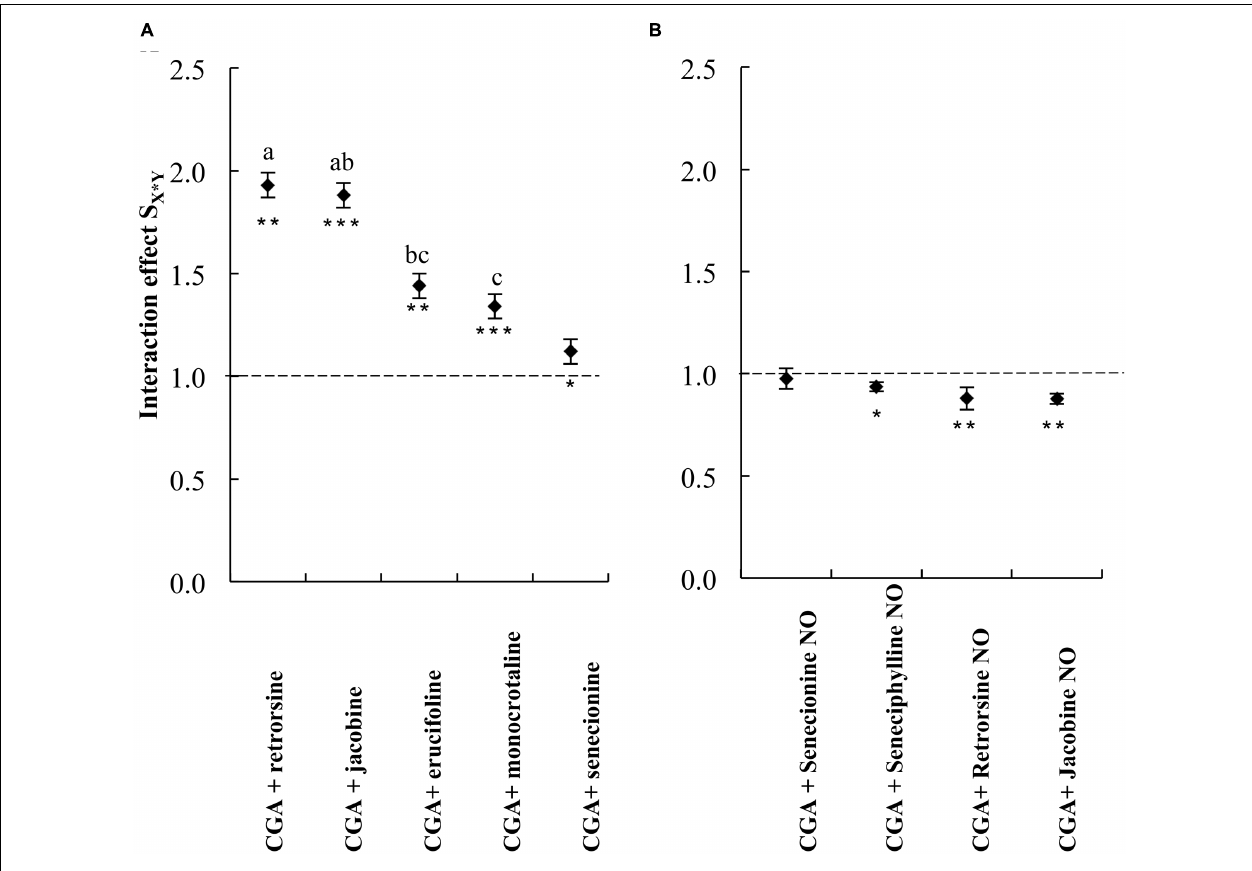
FIGURE 4 | The interaction effect S X ∗ Y on thrips ( F. occidentalis ) larval survival (mean ± S.E.) of the combinations of CGA with five PA free bases (A) and PA N -oxides (B) . Data are from two independent bioassays. Deviation of the interaction effect S X ∗ Y from the dashed line indicates synergistic ( < 1) or antagonistic effect ( > 1). The interaction effects S X ∗ Y were analyzed by a three-way ANOVA with PA, PA concentration and CGA concentration as factors ( Table 2 ). Different letters indicate that the interaction effects with CGA are significantly different among PAs (Tukey post hoc test). Senecionine was excluded from the three-way ANOVAs as it was not tested at higher concentrations. ∗ P < 0.05, ∗∗ P < 0.01, and ∗∗∗ P < 0.001. NO, N -oxide.